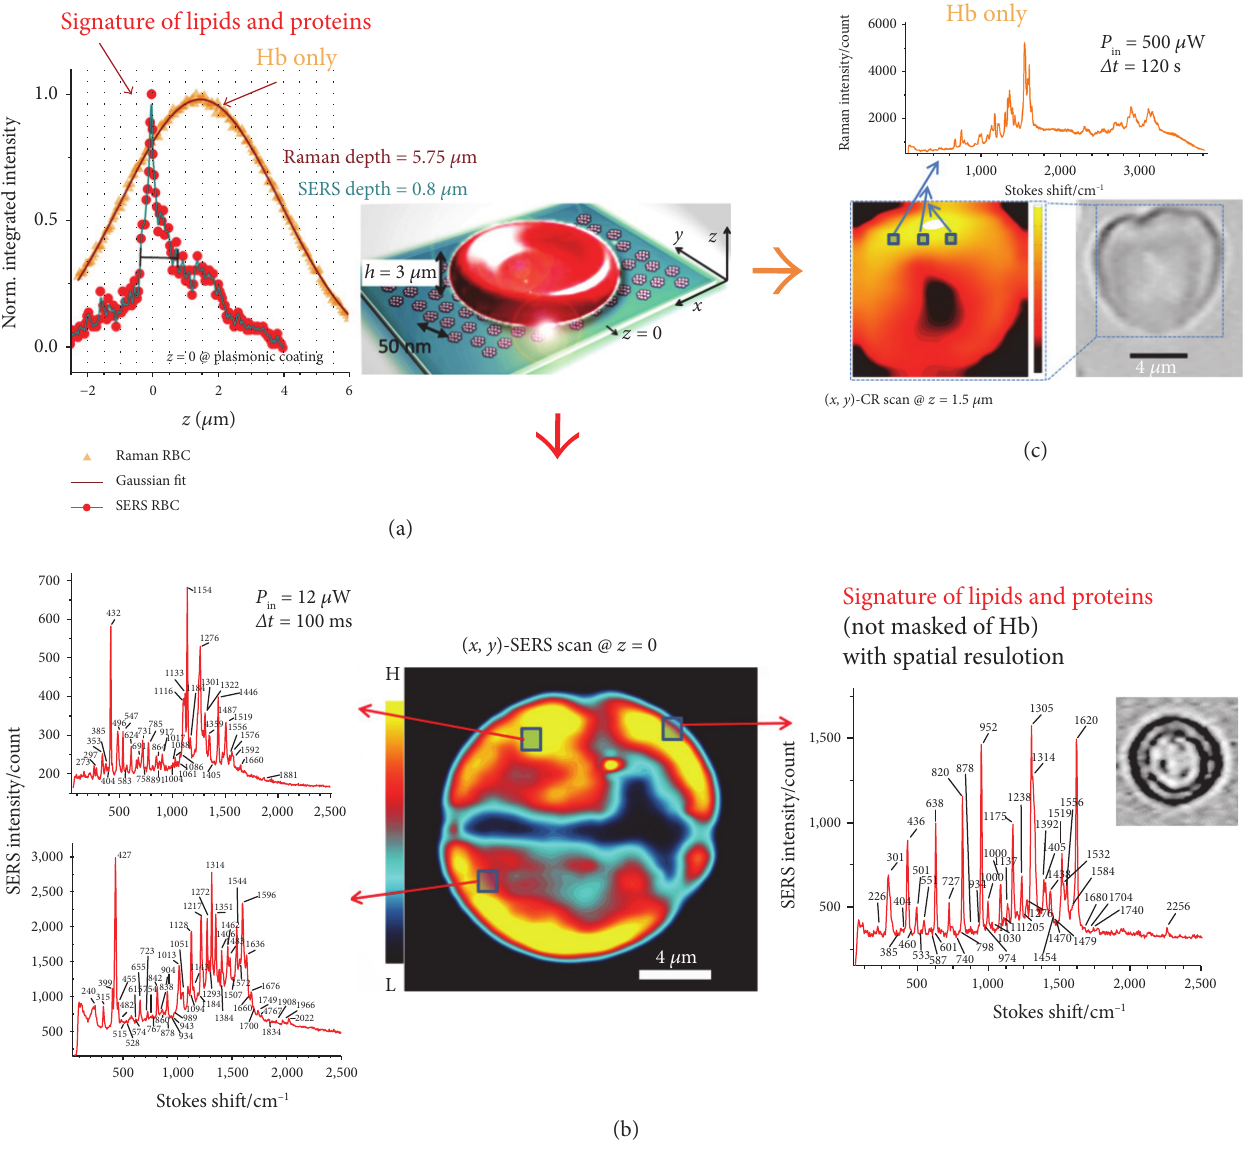
Figure 4: Schematic representation of the experiment with red blood cell on a SERS substrate: the SERS signal is peaked at the SERS substrate z =0 in (a) (red points) and is associated with SERS spectra corresponding to lipids and proteins not masked by Hb as shown in (b). In particular, this is achieved with spatially resolved signals revealing sensitivity to the local membrane environment with capability of reconstructing the membrane SERS map of the RBC, in close correlation with the actual morphology of the cell scanned (see optical image in the inset in (b)). In a twin experiment with a normal coverslip as substrate (not shown), the Raman signal is ascribable only to Hb: the spontaneous Raman intensity (integrated between 1400 and 1600cm − 1 ) versus the axial distance z denotes a broad bell-shaped curve (orange points) to be contrasted to the sharp and localized curve obtained on SERS substrate (red points in (a)). In this case, Raman imaging reveals only the spectral signature of Hb in all the RBC volume with no contribution from membrane, as represented in